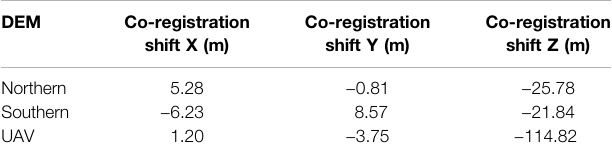
TABLE 3 | Summary of the co-registration shifts for the northern and southern parts of the study area, corresponding to the Corona stripes and the UAV